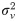
Model selection by Repli-Sim for models with constant and stochastic forks’ speeds.(a) Some models (parameter sets) considered. Stochasticity of replication forks’ speeds (σv2) is shown on the horizontal axis, residual sum of squares (RSS) with experimental data (the lower the better) is shown on the vertical axis, the average forks’ speed (v) is color coded, as shown in the color-bar. Best models (smallest RSS value) are more stochastic. The best selected constant speed model had parameters (σt2=5.7min2, texp = 50min, v = 1.4kb/min, σv2=0(kb/min)2) and the best variable speed model was (σt2=9.7min2, texp = 42min, v = 1.5kb/min, σv2=0.9(kb/min)2). The texp and fork speed from experimental data are 40min and v = 1.6(kb/min), which are more compatible with the variable fork progression model. (b, c) The distribution of DNA tracks for both best stochastic (b, orange) and constant (c, blue) forks’ speeds models are shown along with the distribution of DNA tracks from experimental data (gray), which shows a better fit for the stochastic forks’ speeds model. The average distance traveled in the stochastic forks’ speeds model is compatible with the experimental data (∼105kb).